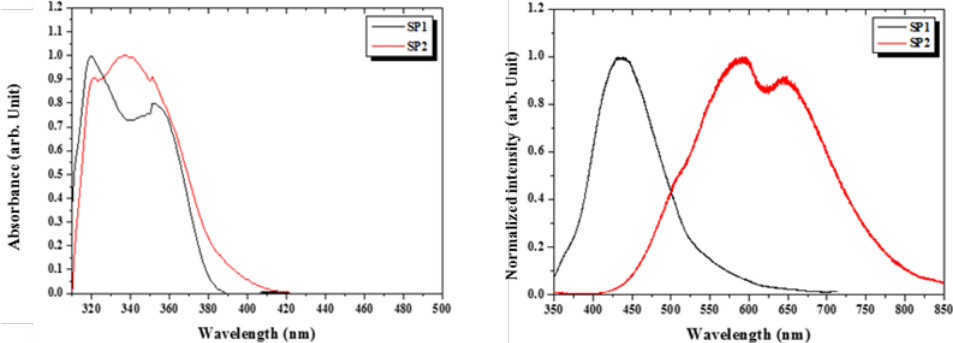
Figure 5. UV-visible absorption and photoluminescence (PL) spectra of diphenylacridine (SP1) and phenothiazine (SP2).